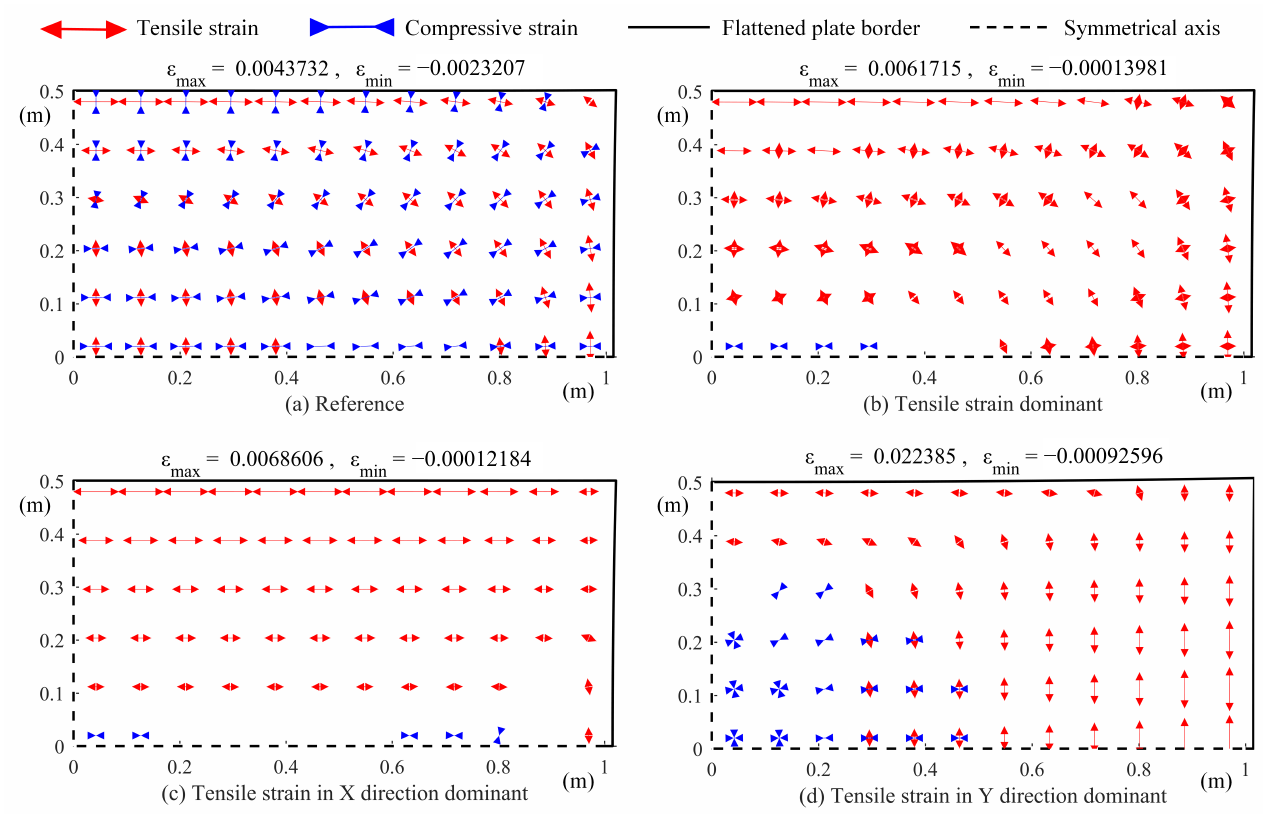
Figure 10. Principal membrane strain vector of pillow-shape flattening ( a ) reference, ( b ) tensile strain dominant, ( c ) tensile strain in X direction dominant, ( d ) tensile strain in Y direction